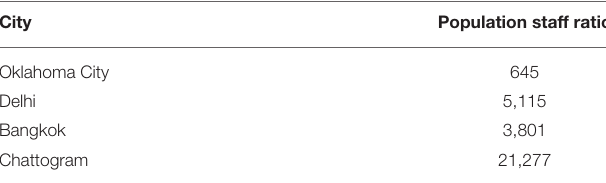
TABLE 4 | Population:staff ratio in different